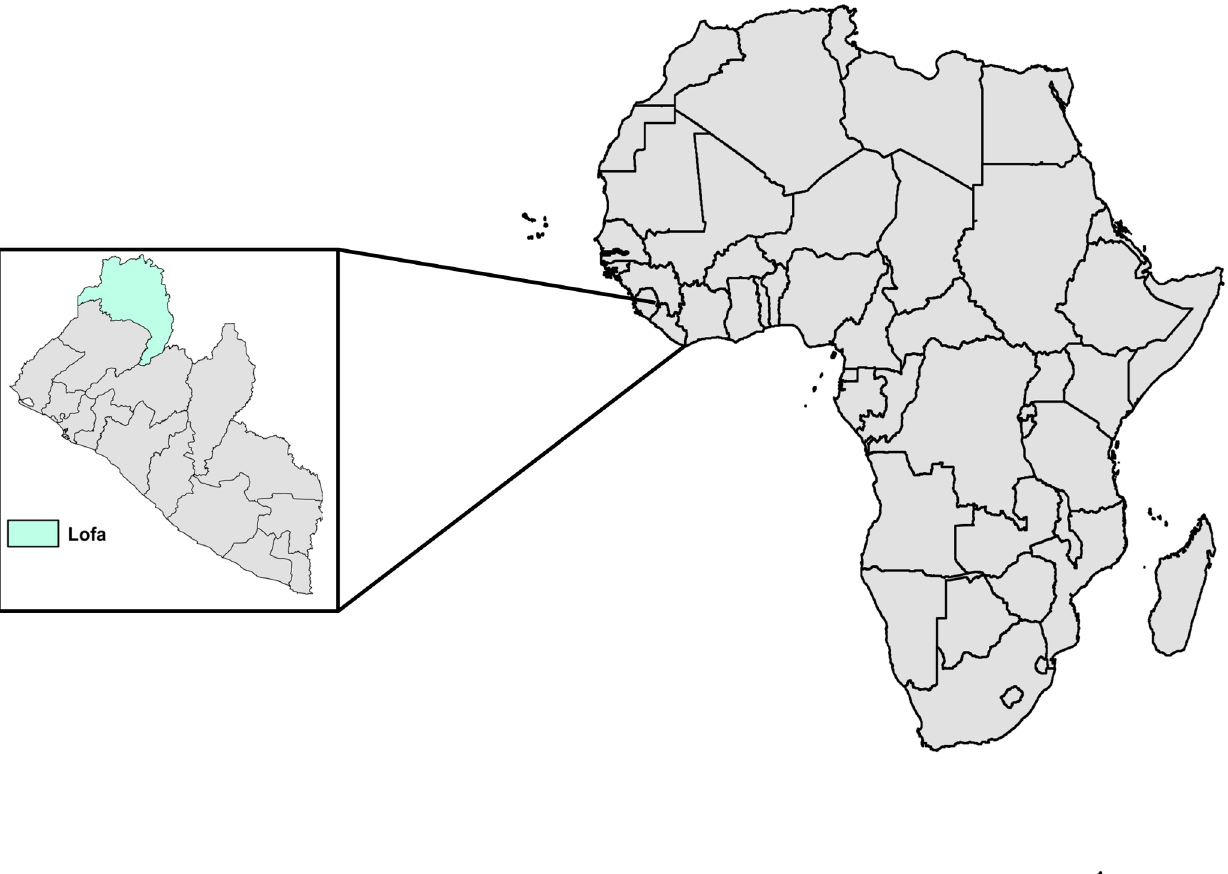
Fig 1. Households from two villages in northern Liberia were enrolled into the study. The two study villages were located in rural Lofa County, Liberia and made up of ~30 households each. Both Village A and Village B were visited by the research team consisting of researchers from CSU and LIBR, as well as a nurse and local public health worker. A total of 23 households from Village A and 20 households from Village B were enrolled into the study. Map made with free online tool at